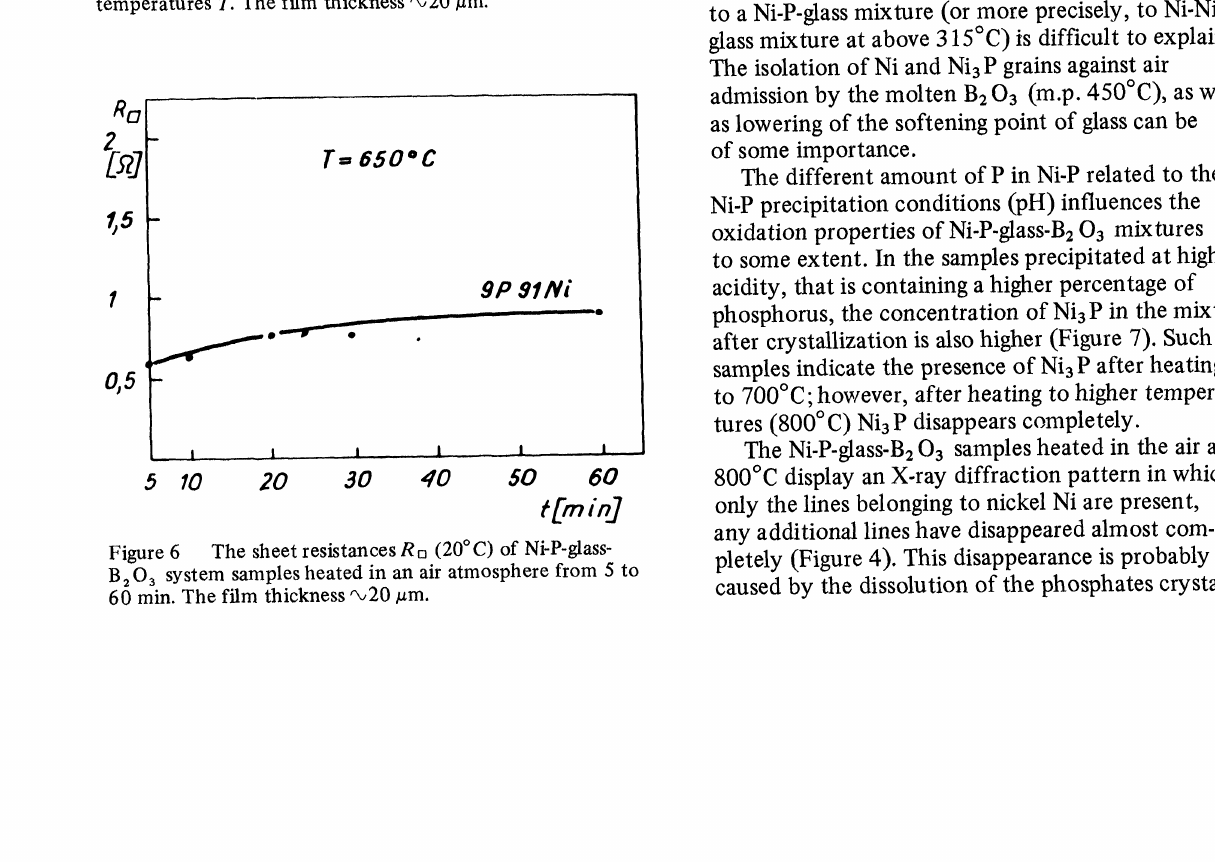
The sheet resistances R (20 C) of Ni-P-glass- B O system samples heated in an air atmosphere at different temperatures T. The film thickness 20 m.